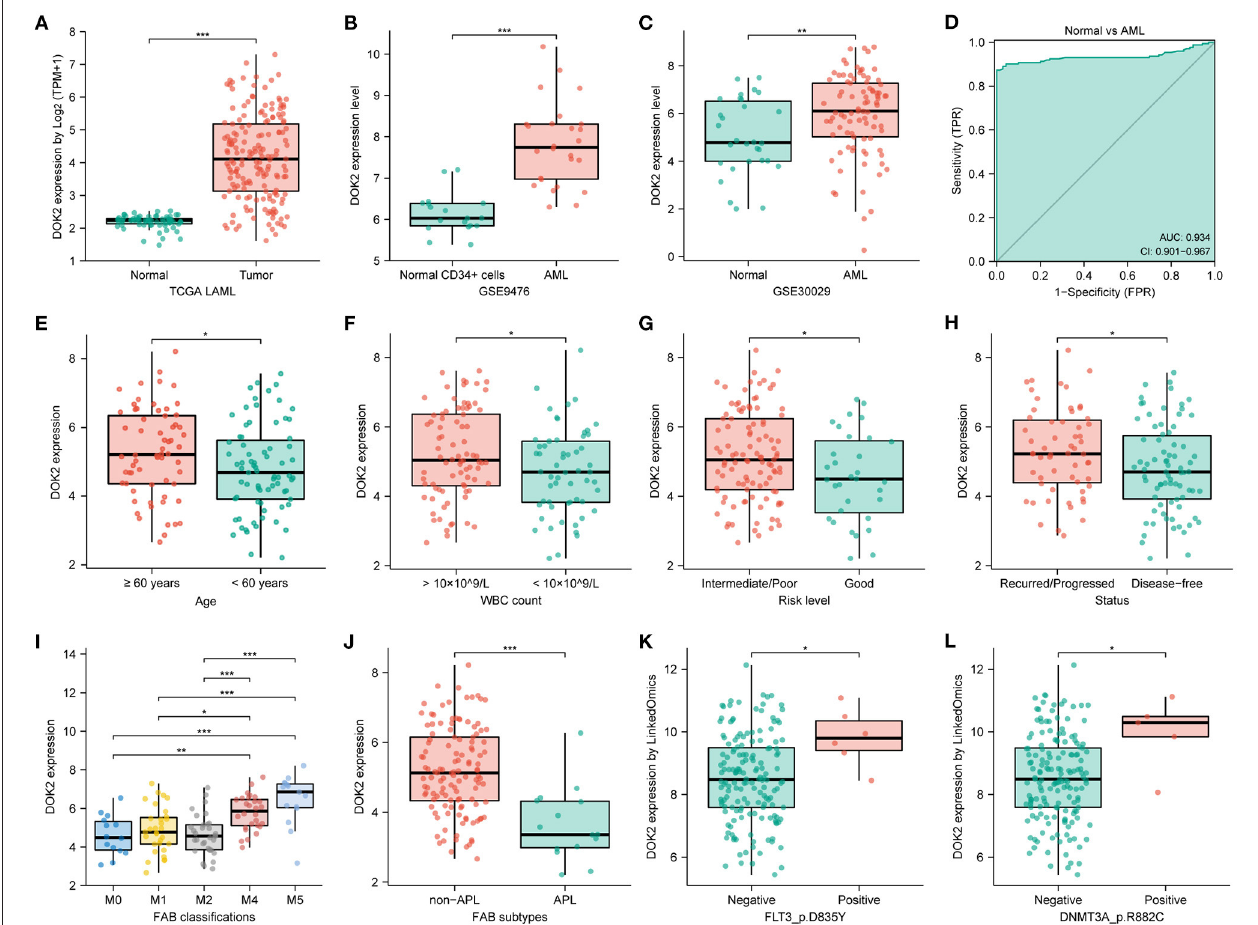
FIGURE 1 | DOK2 mRNA expression levels in AML patients. (A) The transcription levels of DOK2 from the TCGA. (B) Transcription levels of DOK2 in GSE9476. (C) Transcription levels of DOK2 in GSE30029. (D) The ROC curve for DOK2 in the TCGA AML vs. normal. (E–J) Association of DOK2 expression with age, WBC count, risk level, recurred/progressed status, FAB classification (M0, M1, M2, M4, M5), and APL subtype in the TCGA cohort. (K,L) Associations of DOK2 expression with FLT3 p.D835Y mutation and DNMT3A p.R882C mutation by LinkedOmics. * P < 0.05, ** P < 0.01, *** P < 0.001.